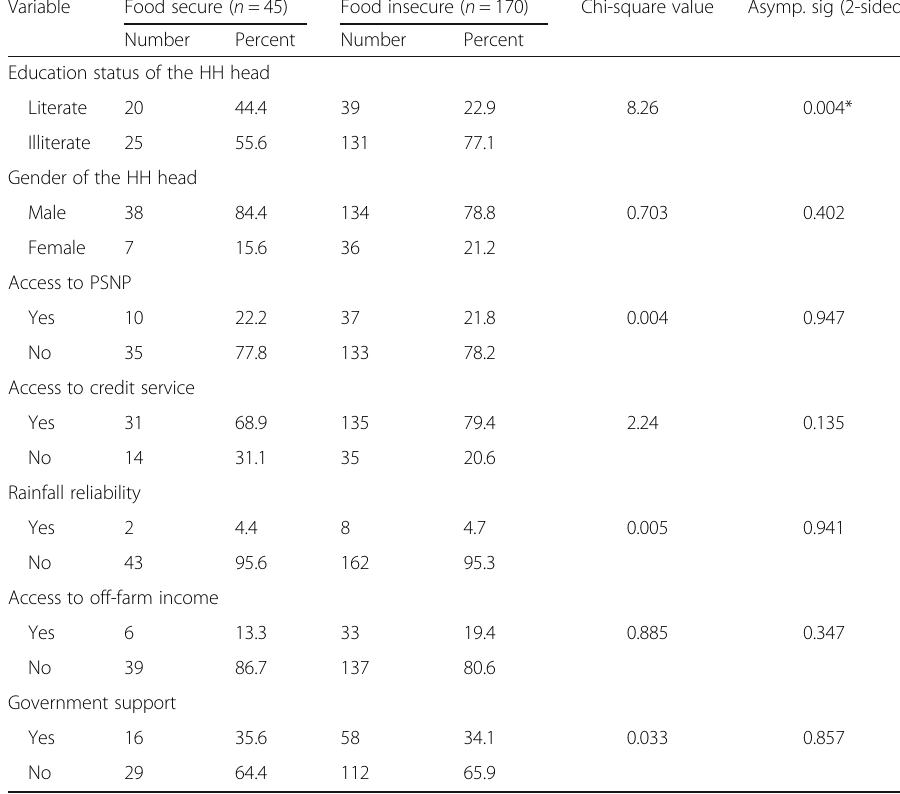
Table 4 Descriptive summary of discrete variables